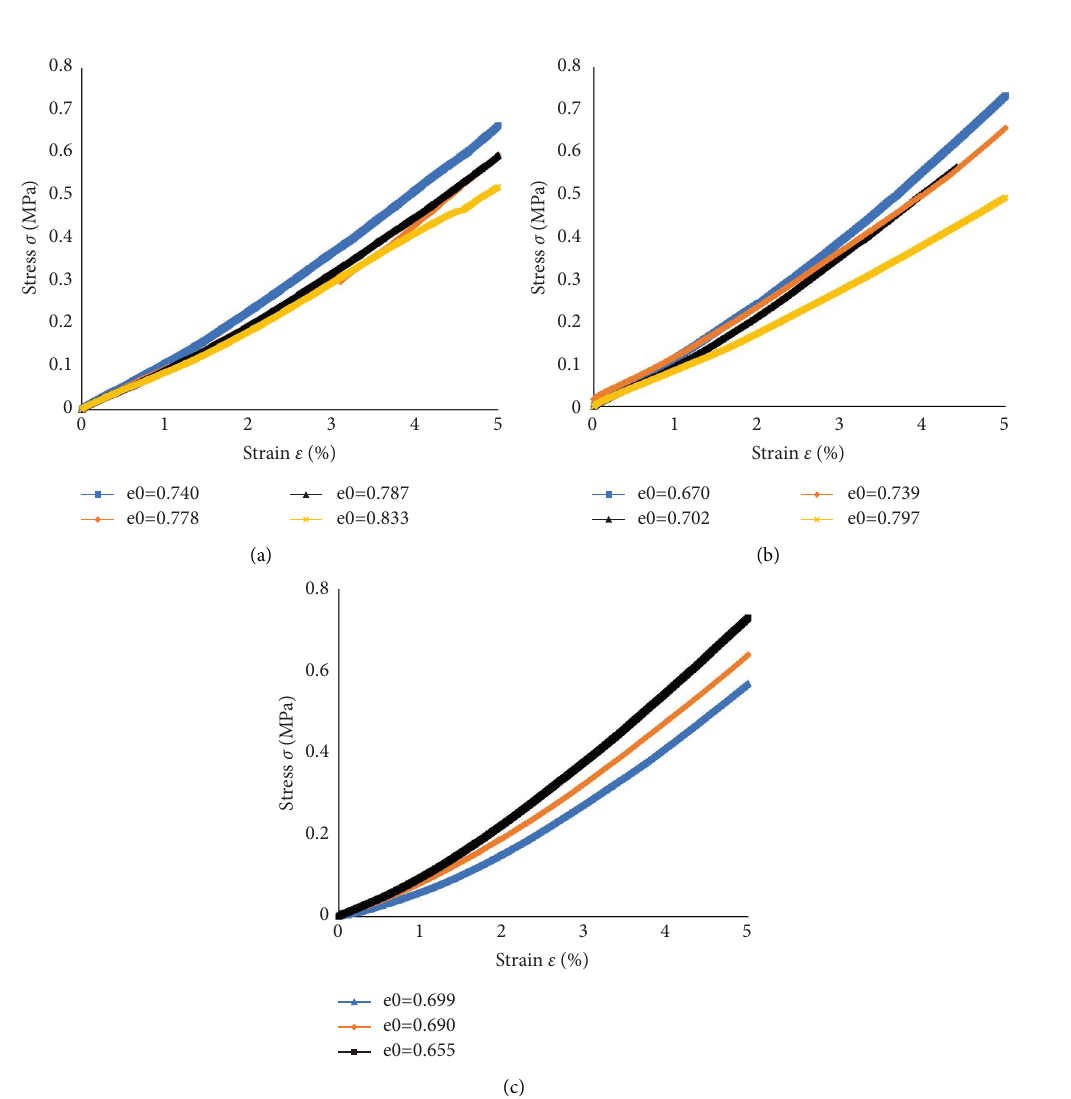
Figure 5: Stress-strain curves. (a) R d �